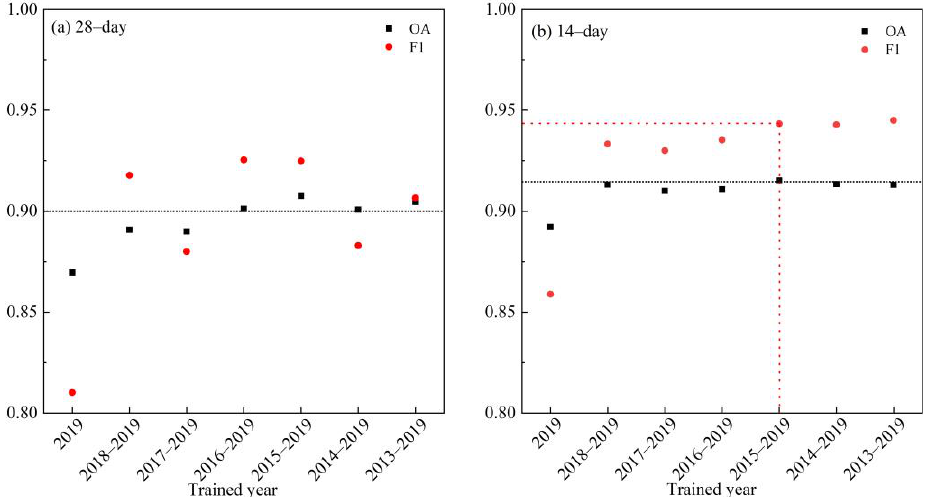
Figure 9. Extraction accuracies based on training samples of multiple years. ( a ) Using the data (with time interval of 28 days) of different numbers of continuous years ending in 2019 to predict crop types in 2020; ( b ) Using the data (with time interval of 14 days) of different numbers of continuous years ending in 2019 to predict crop types in 2020.